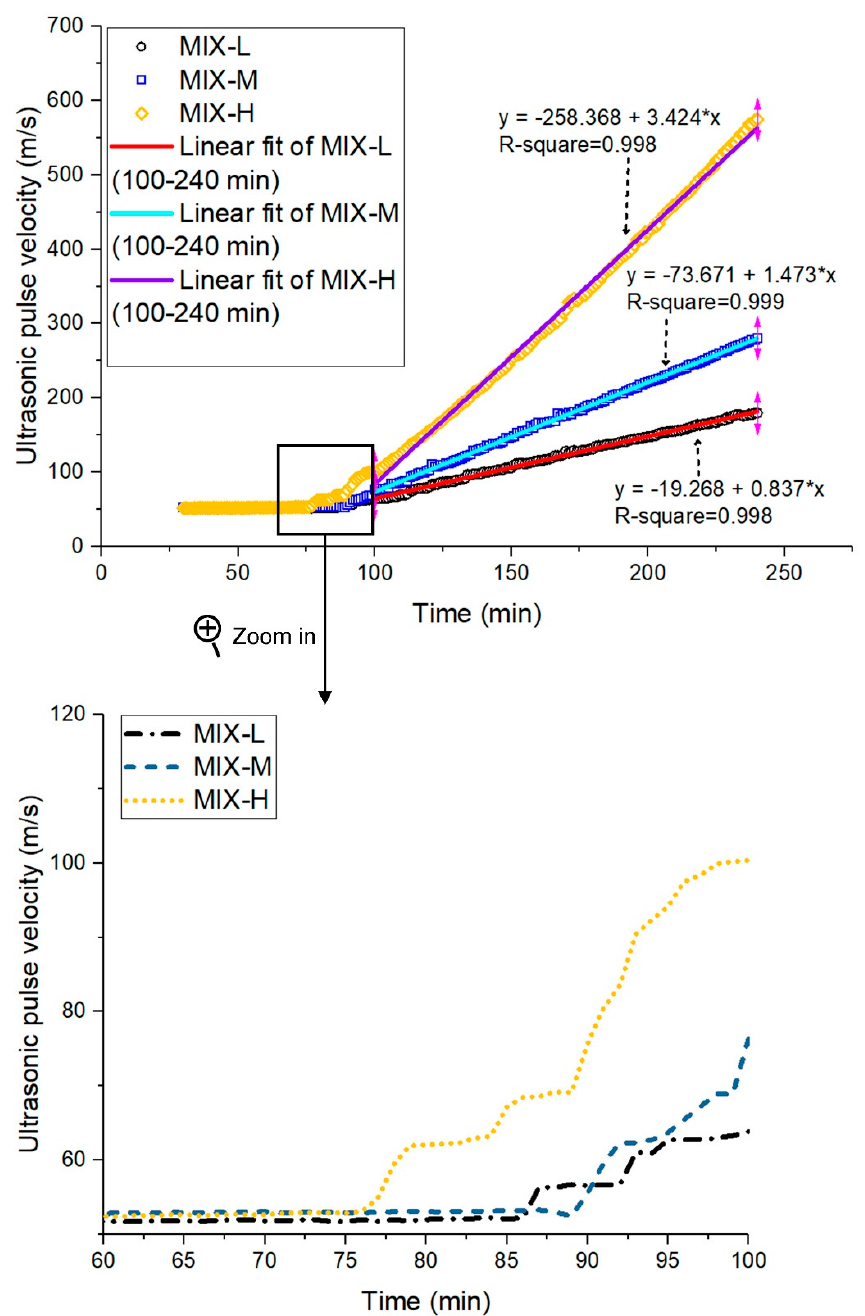
Figure 11. Measuring results of ultrasonic pulse velocity for mixtures MIX-L, MIX-M and MIX-H. The linear fit based on measuring results from 100 min to 240 min.